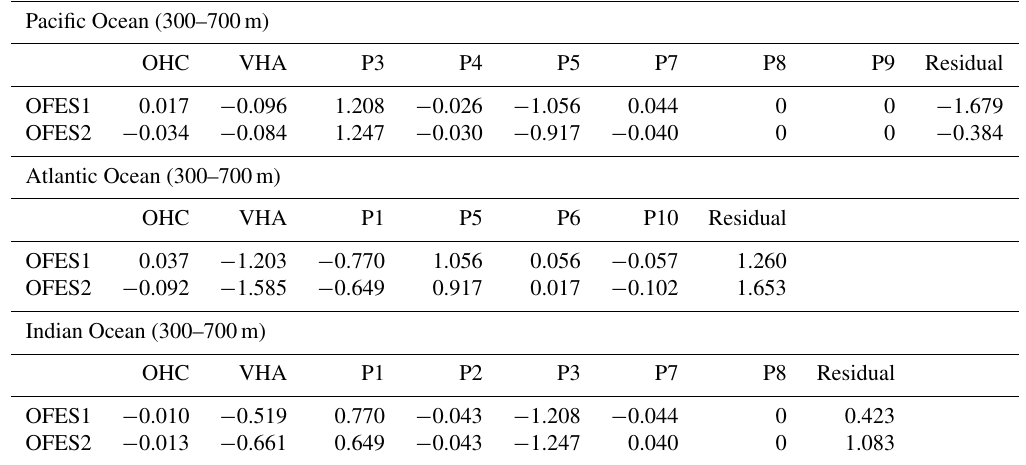
Table 3. As for Table 2 but for the middle layer (300–700m). VHA is at a depth of 700m in this table. Pacific Ocean